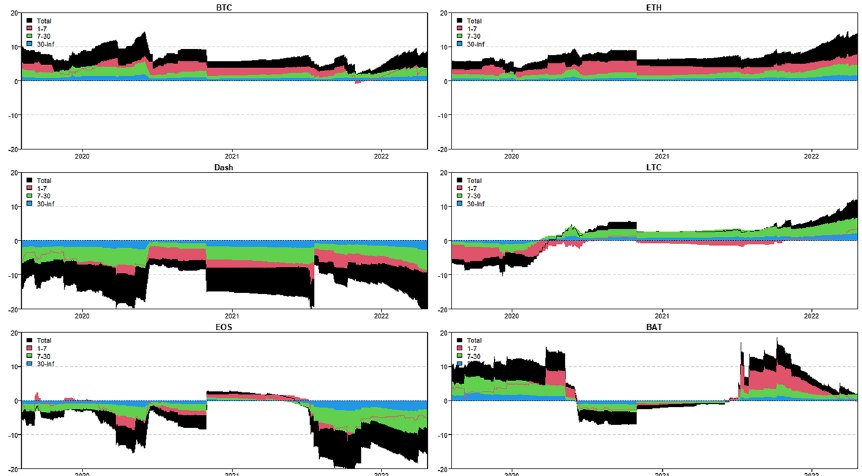
Fig. 27 Dynamic net connectedness—realized hyperkurtosis (RHK)